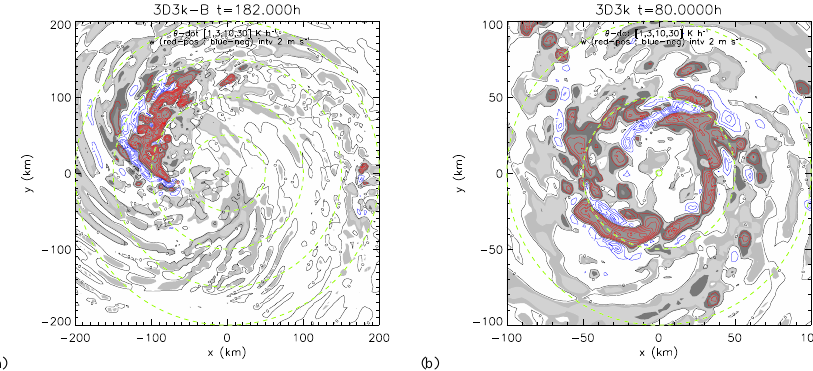
Fig. 22. Plan-view plots at the z =5 km level during rapid intensification for (a) simulation 3D3k-B (’low drag’) at 182 hours and (b) simulation 3D3k (’realistic drag’) at 80 hours of vertical velocity w with contour interval 2 m s − 1 (blue negative; red positive) and diabatic Fig. 22. Plan-view plots at the z = 5km level during rapid intensification for (a) simulation 3D3k-B (“low drag”) at 182 h and (b) simulation heating rate ˙ θ with shading levels of 1, 3, 10, and 30 K h − 1 . The dashed green rings are constant radii spaced at 50 km from storm centre. 3D3k (’realistic drag’) at 80 h of vertical velocity w with contour interval 2ms − 1 (blue negative; red positive) and diabatic heating rate ˙ θ with shading levels of 1, 3, 10, and 30Kh − 1 . The dashed green rings are constant radii spaced at 50km from storm fluctuations persist for a longer period in the low drag sim- ulation. Fifth, in the low drag simulation, large values of heating rate extend to significant radii ( ∼ 200 km ) for much of the simulation. In the AX simulations, the <M > surface that marks the RMW has an initial radius of 150 km in the case of reduced drag compared with 90 km in the case of standard drag, al- thoughthe final radiusis about the same in both cases shown in Fig. 23( ∼ 20km). Thetime taken fortheminimumRMW to be achieved is significantly greater in the case of reduced drag ( ∼ 200 h) compared to that of standard drag ( ∼ 100 h). As discussed above, the increased boundary-layer conver- gence associated with an increase in C D would help to ex- plain the faster spin-upin the AX configuration. However,in